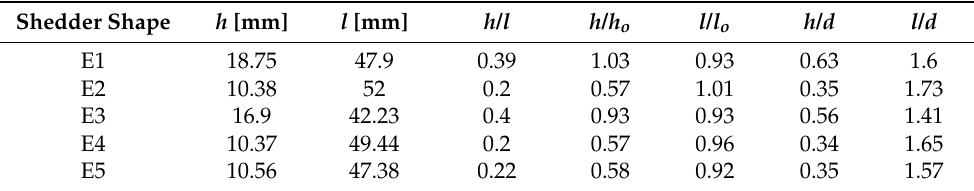
Table 4. Influence of changing the shape of the vortex shedder bar on the average dimensions of the vortex